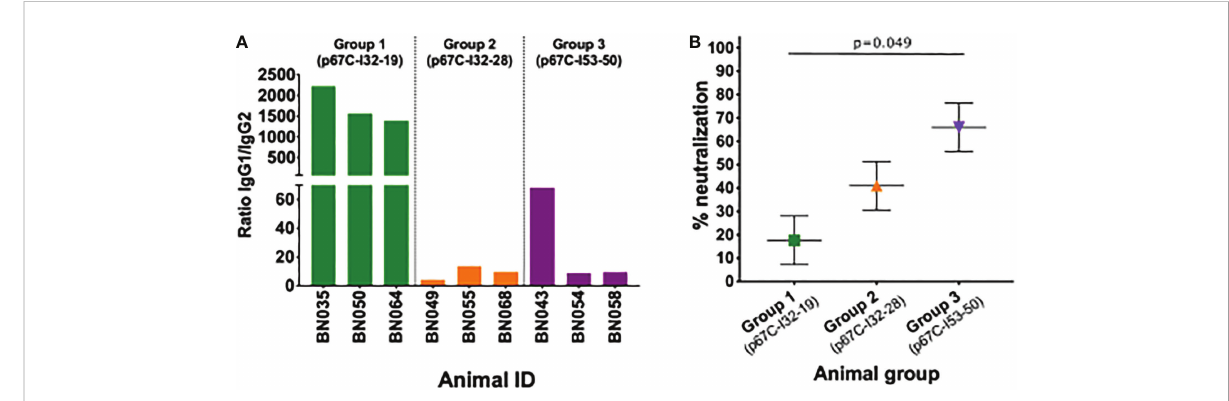
FIGURE 3 IgG subtypes and neutralizing capacity of sera. (A) Detection of IgG subtypes at day 77 is expressed as the ratio of IgG1 to IgG2 anti-p67C responses. (B) Neutralization capacity of serum of animals immunized with p67C-I32-19 (Group 1), p67C-I32-28 (Group 2) or p67C-I53-50 (Group 3) at day 77. The results are presented as the percentage of reduction of infection compared with the pre-immunization sera from the same animals. Individual animals, mean and standard error of the mean bars are presented. Group 1 and 3 showed signi fi cant differences when applying multiple comparison with Holm adjustment after linear regression (p=0.049).